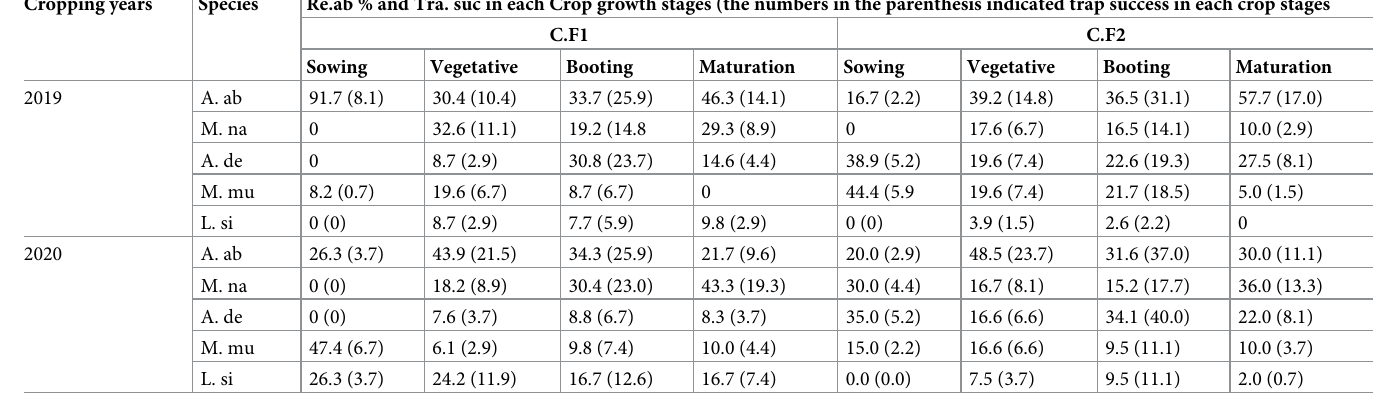
Table 2. Relative abundance and trap success of rodent pests at different growth stages of barley crop during 2019 and 2020 cropping seasons (A.ab = A . abyssinicus , M.na = M . natalensis , A.de = A . dembeensis , M.mu = M . musculus , L.si = L . simensis , Tra.su = trap success, Re.ab = relative abundance, C.F1 = crop field near the for- est and CF2 = crop field away from the forest).